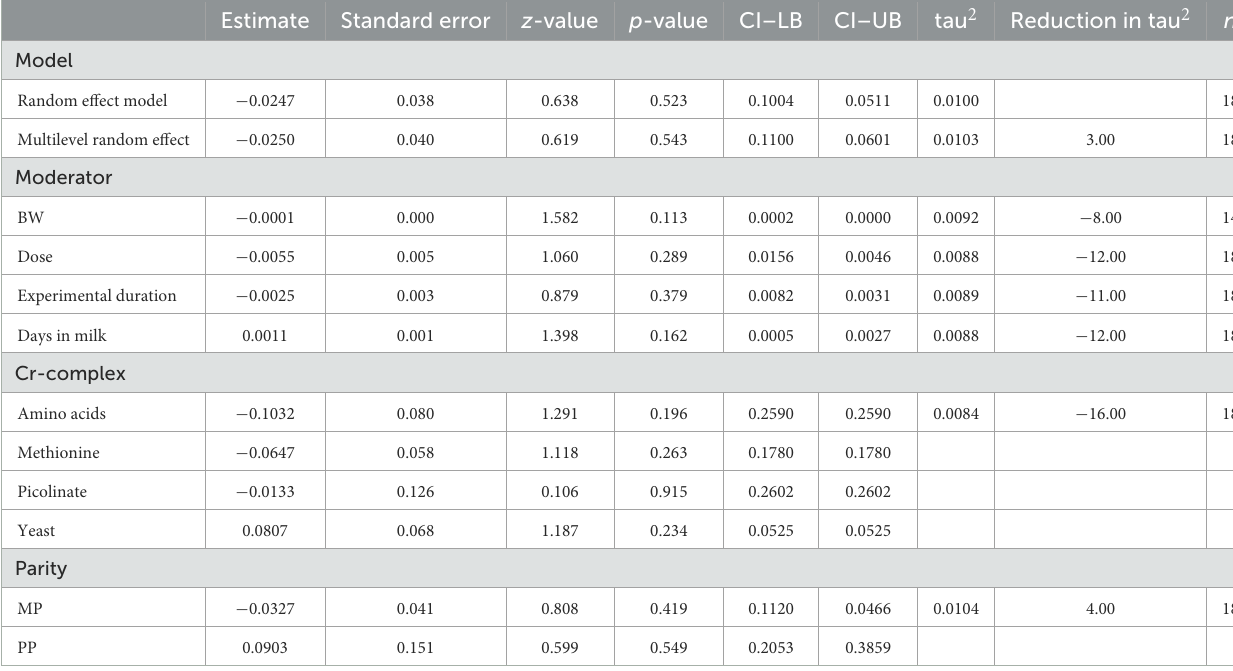
TABLE 6 A summary of statistical models and moderators for solids-not-fat meta-analysis.